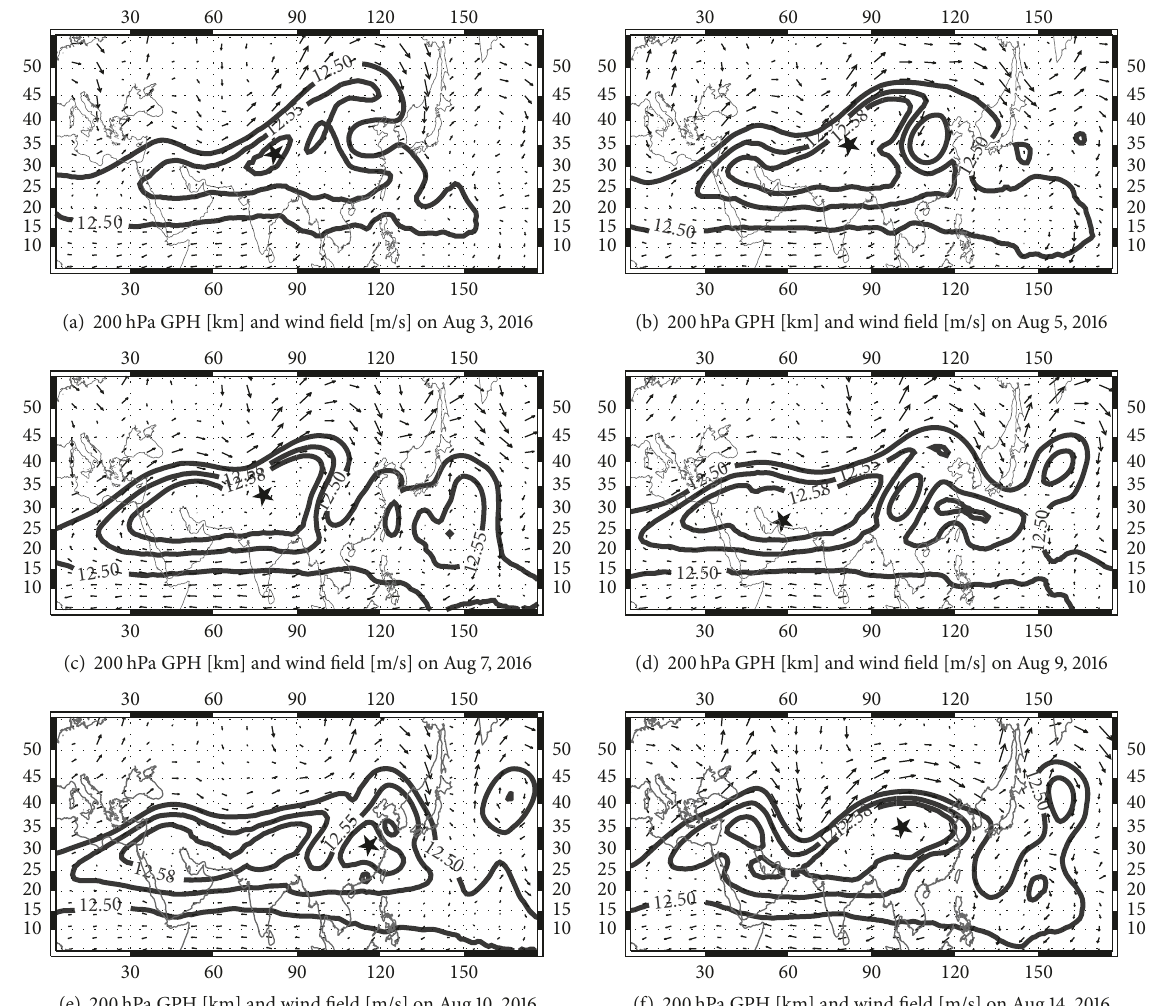
Figure 2: The same as Figure 1, but at 200 hPa. The GPH contours are 12.50 km, 12.55 km, and 12.58